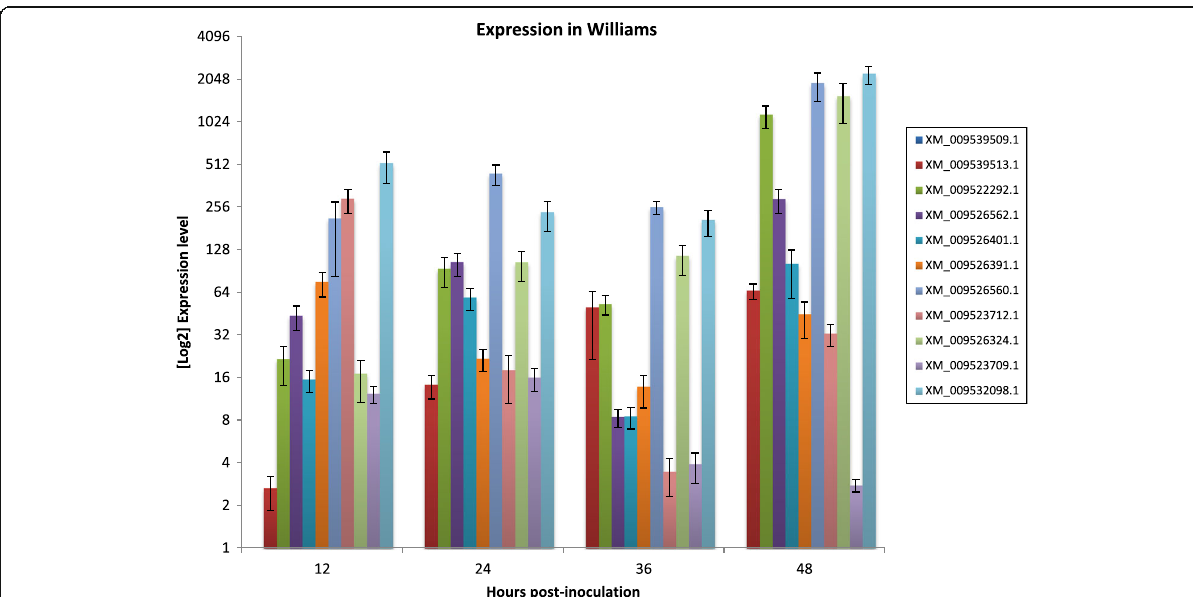
Fig. 5 qRT-PCR analysis of P. sojae PL3-coding genes at several time points after inoculation of soybean plants (cv Williams) with P. sojae . Fold expression was calculated by the Livak ( ΔΔ Ct) method using mycelia expression as the calibrating sample and actin as the reference gene. Bars